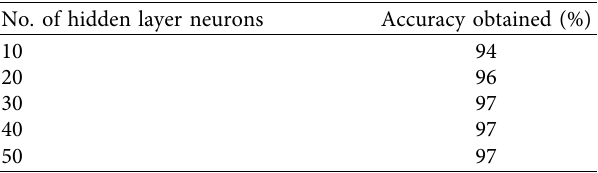
Table 10: Effect of hidden layer neuron of validation. No. of hidden layer